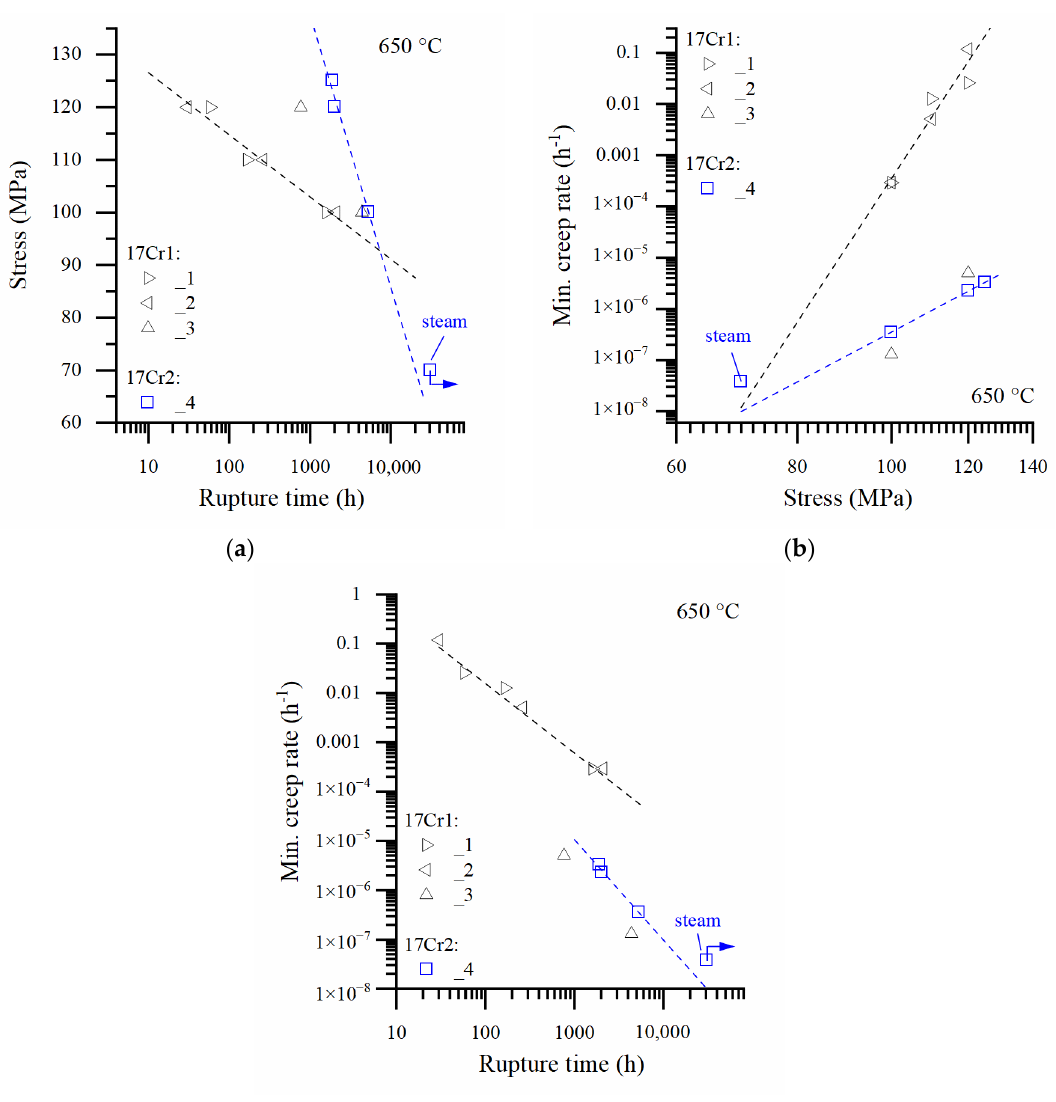
Figure 5. Summary of 650 °C creep properties: ( a ) stress vs. rupture time, ( b ) minimum creep rate vs. stress, and ( c ) minimum creep rate vs. rupture time (arrows indicate experiments in progress; data excluded from fitting).